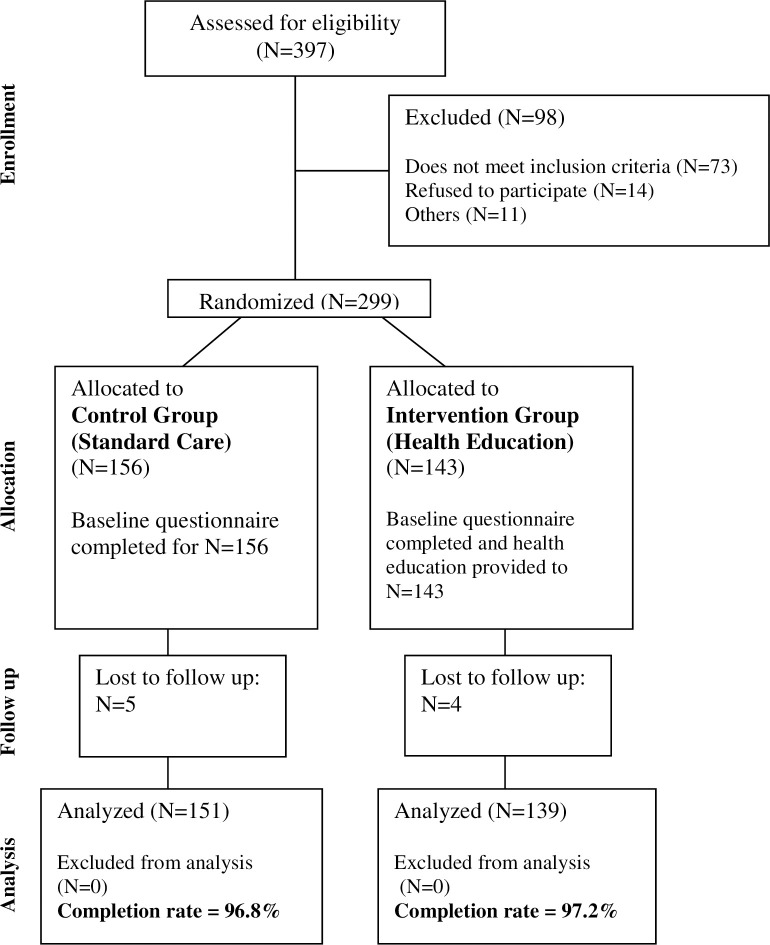
CONSORT flowchart.